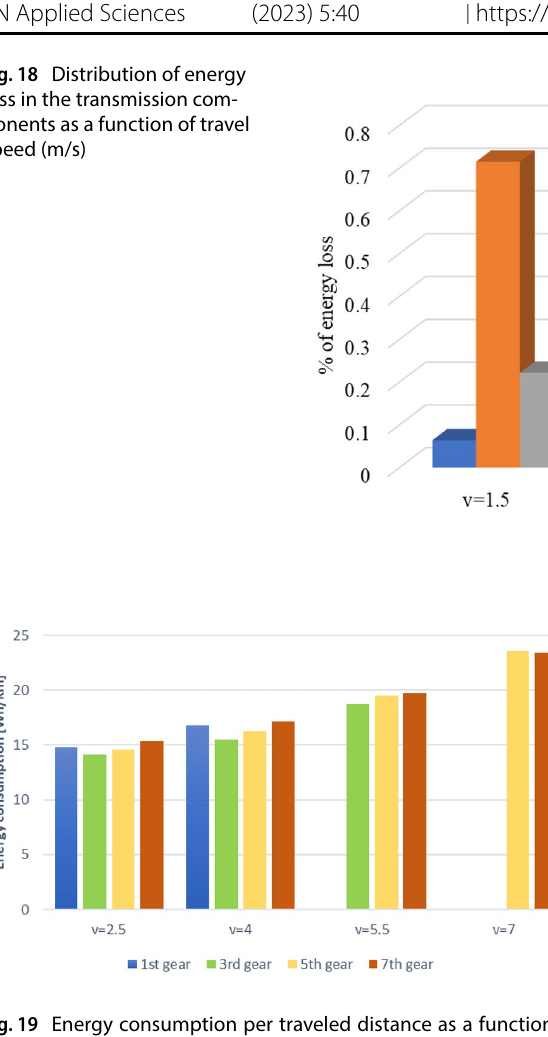
Fig. 19 Energy consumption per traveled distance as a function of travel velocity and gear